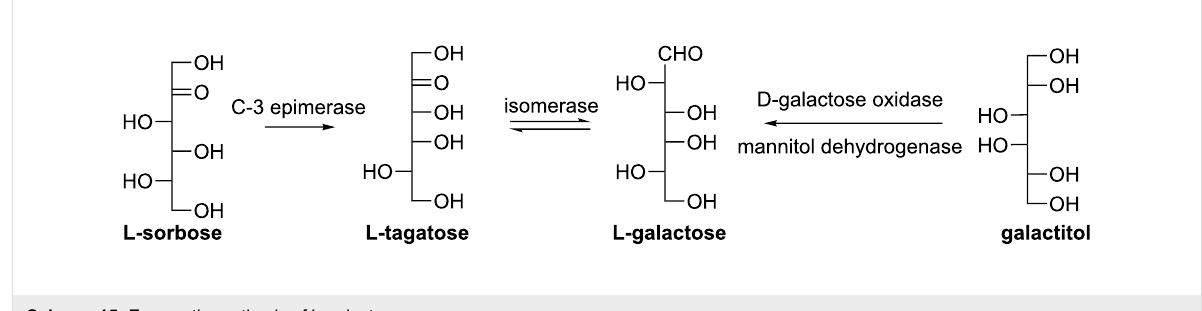
Scheme 15: Enzymatic synthesis of